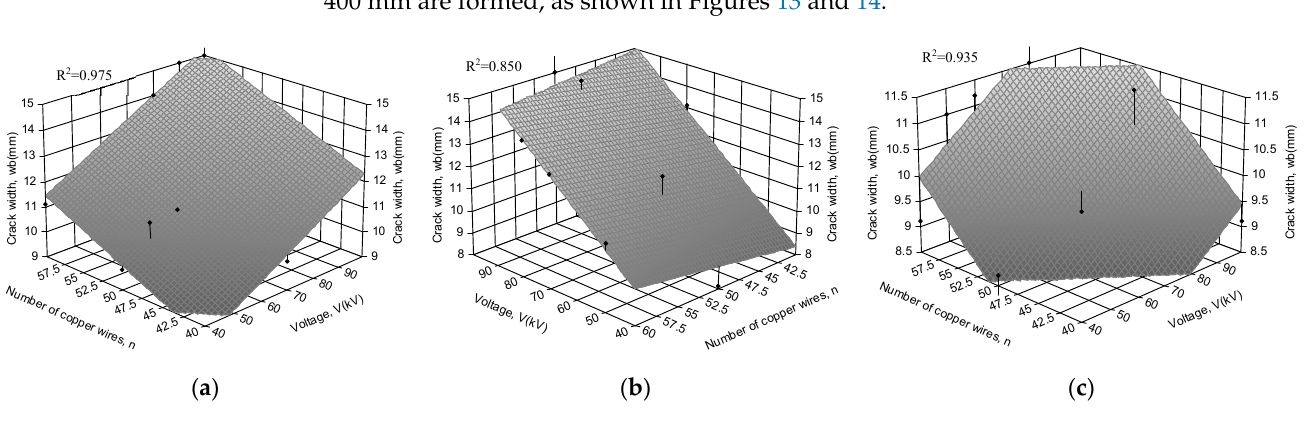
at 400 mm hole spacing.